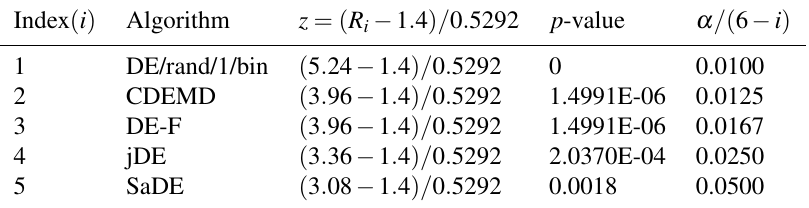
Table 7. Results of the Holm procedure( D =30, α